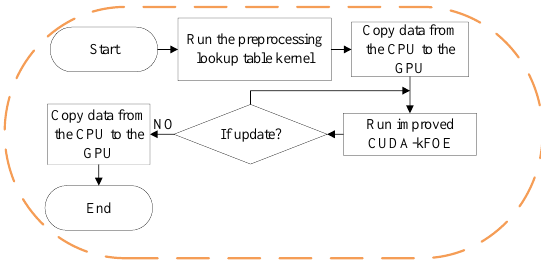
Figure 3. Improved CUDA-kFOE algorithm